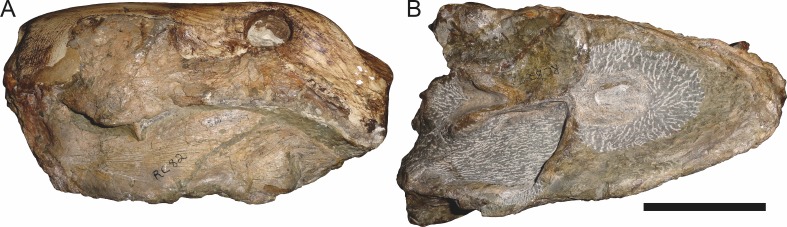
Referred specimen (RC 82) of Smilesaurus ferox
Broom, 1948 in (A) left lateral and (B) ventral view.Holotype of Pardocephalus wallacei
Broom, 1948. Scale bar equals 10 cm.